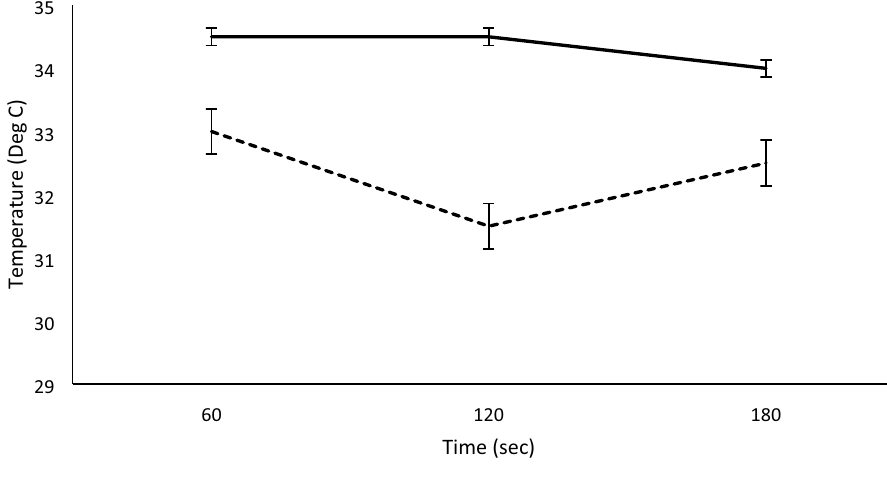
Fig. 3 Temperature of homog- enization tubes internally and externally was measured throughout the homogeniza- tion process. Note that the homogenization tubes never surpassed 35 C, maintaining the cannabinoids well under the 90 C benchmark that causes conversion from the acidic to neural